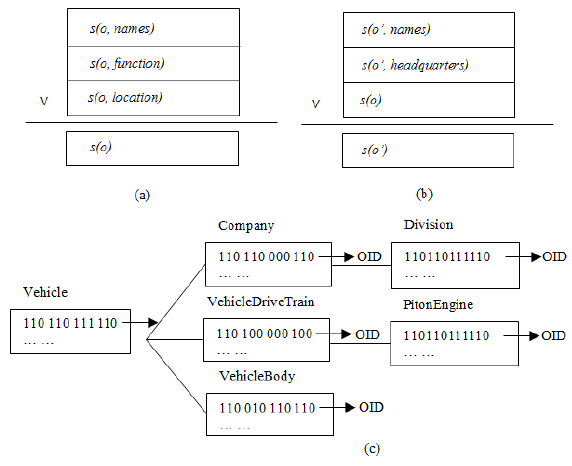
Figure 2. Signature and signature file